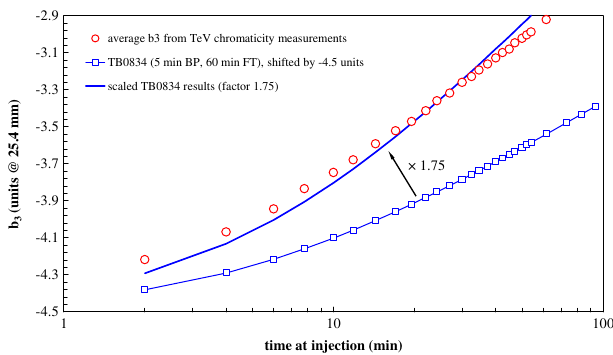
FIG. 6. (Color) Comparison of the sextupole deduced from chromaticity measurement during an injection at Tevatron, and the scaled measurements in a spare dipole. The scaling factor was optimized to minimize the residual error over the complete injection plateau, of 100 minutes.